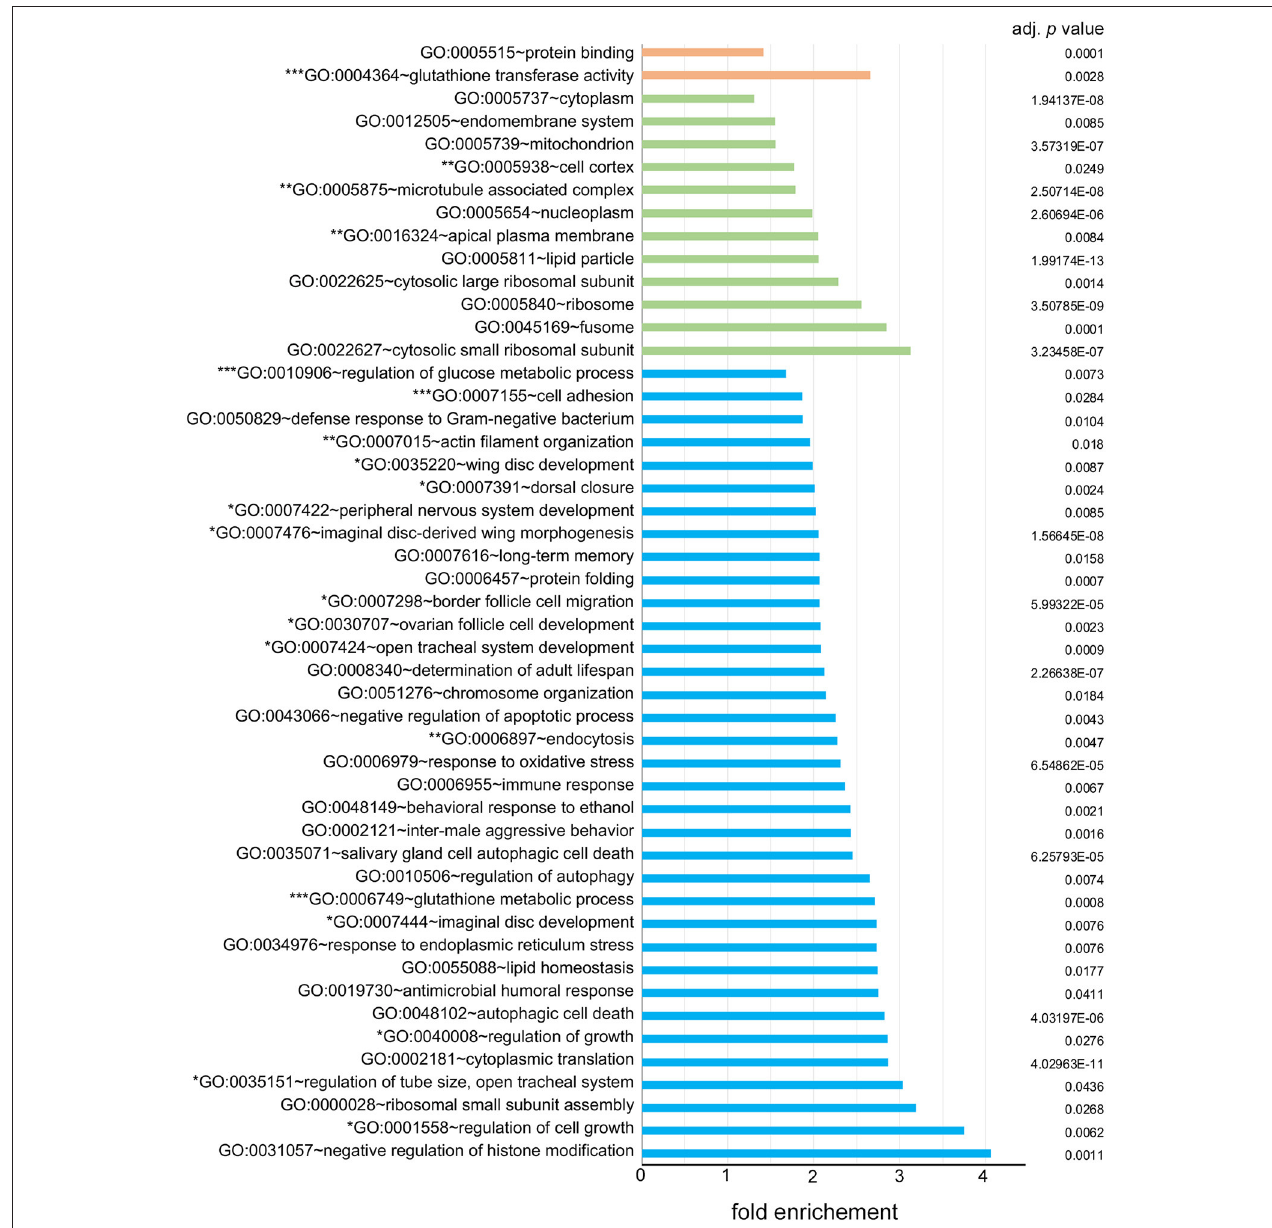
FIGURE 2 | Over-represented gene ontology (GO) terms of the carpet glia transcriptome. All GO terms in three fields, biological process (BP) labeled in blue, cellular component (CC) labeled in green, and molecular function (MF) labeled in orange, with a Benjamini-adjusted p < 0.05 are listed. Enrichment shown on the x -axis represents the fold increase in the number of genes in each GO term over the number expected by chance. GO terms with one, two, and three asterisks (*) are categorized in groups 1, 2, and 3 described in the text,